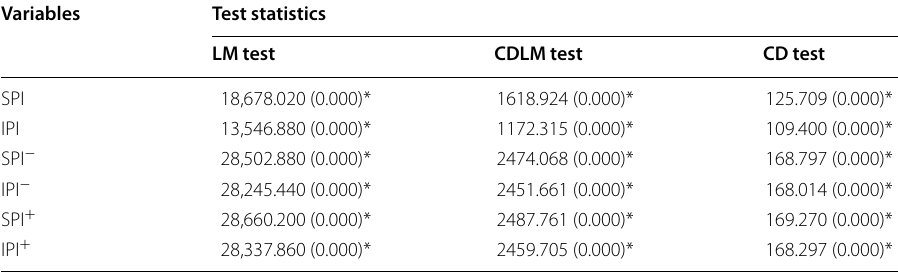
The numbers in the parentheses show the p values *The significance at the 1%